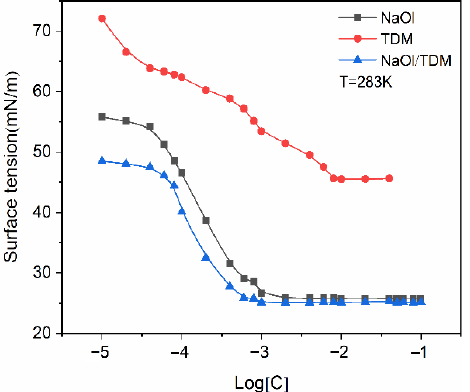
Figure 6. Surface tension for the individual collectors NaOl and TDM and the mixed collector NaOl/TDM at 283 K. NaOl/TDM at 283 K. Table 2. Surface and thermodynamic properties of NaOl, TDM and NaOl/TDM at 283 K.